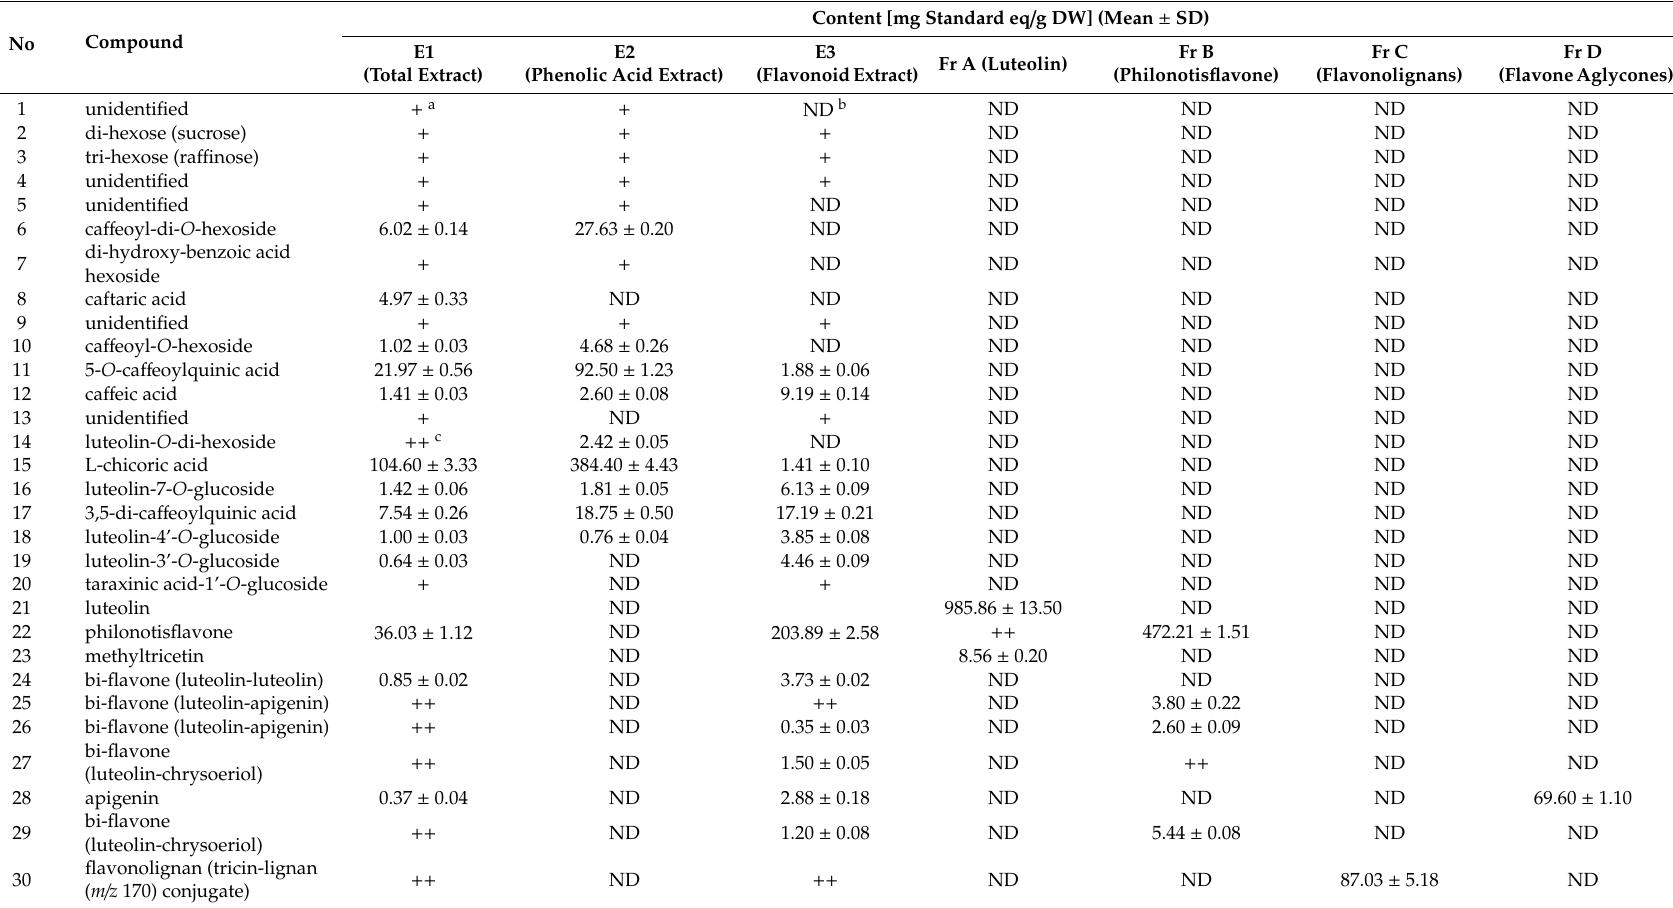
Table 2. Comparison of phytochemical profile and phenolic content in tested extracts (E1–E3) and fractions (A–D) of dandelion